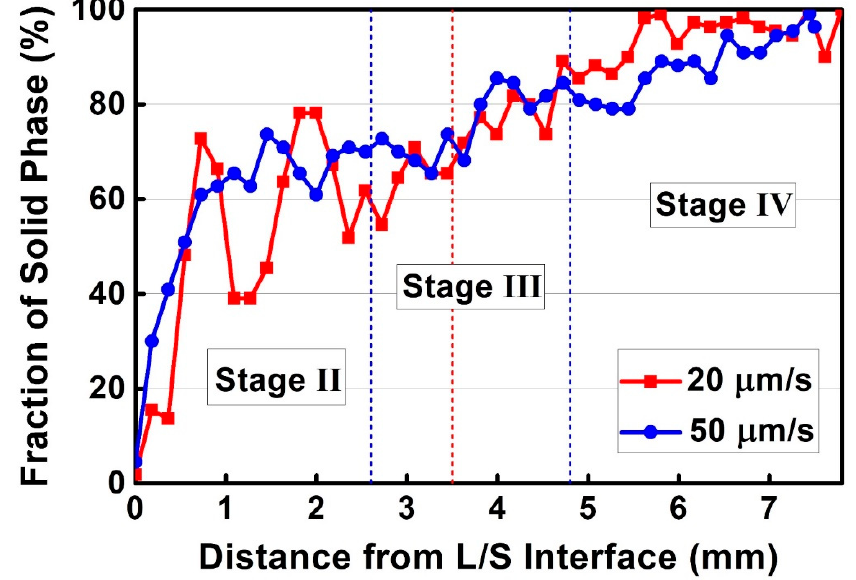
Figure 7. Volume fractions of solid phase in the mushy zones of as-cast alloy 3C2N during the LMC-DS process under withdraw rates of 20 and 50 µm/s.